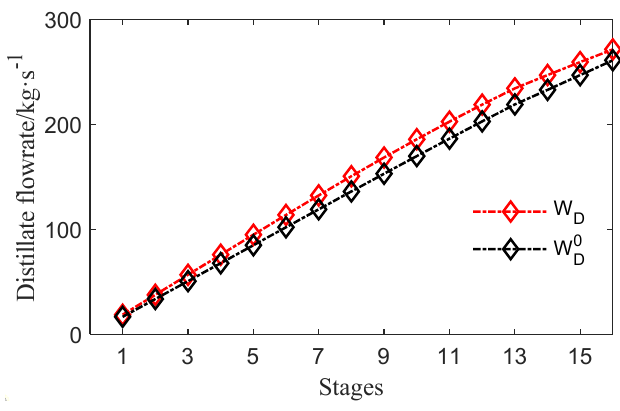
Stages W W Figure 11. W Dj distribution Figure 11. Dj distribution comparison. Figure 11. Dj distribution comparison.